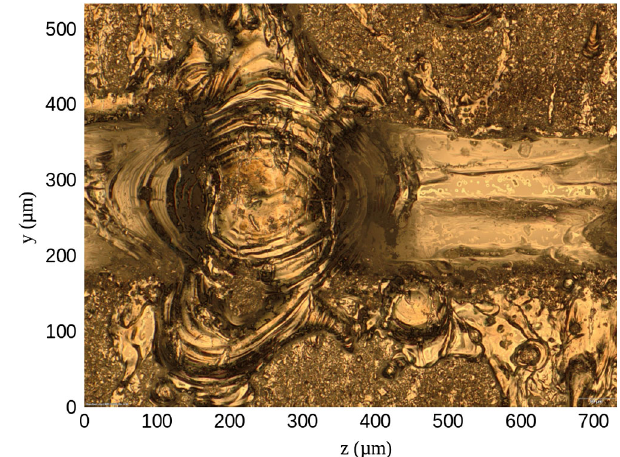
FIG. 28. Flattened image of the SN08, 200 mA beam dump at location z 1 . A large variation of trench depth occurs at this position.